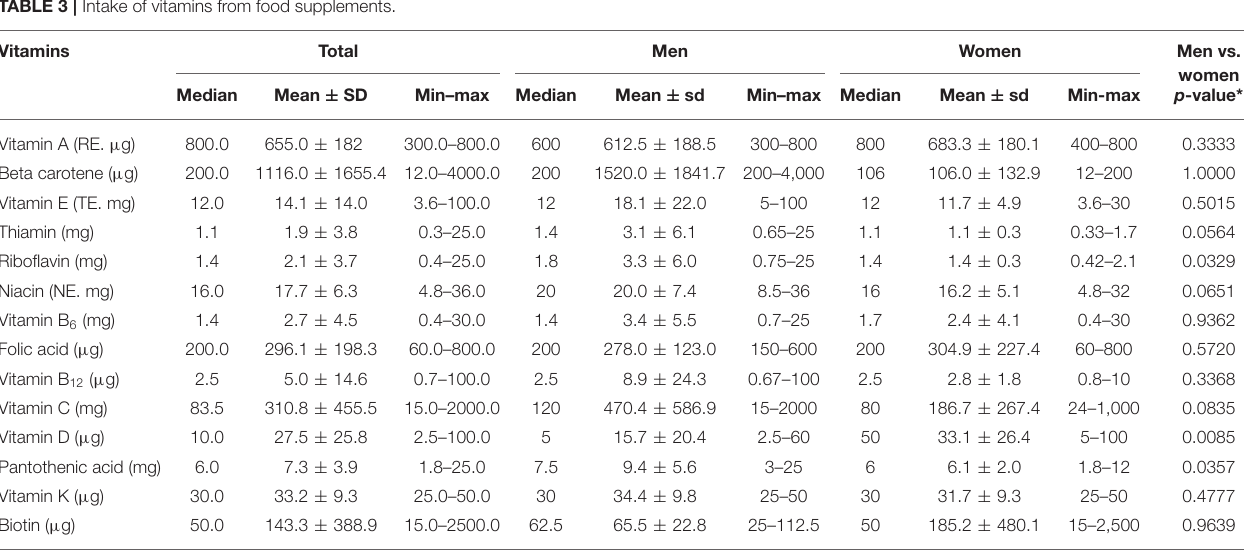
TABLE 3 | Intake of vitamins from food supplements.